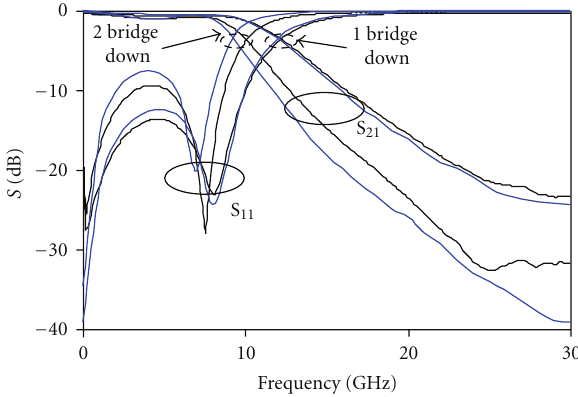
Figure 5: Comparison of the filter performances between simulated (blue line) and measured results (black